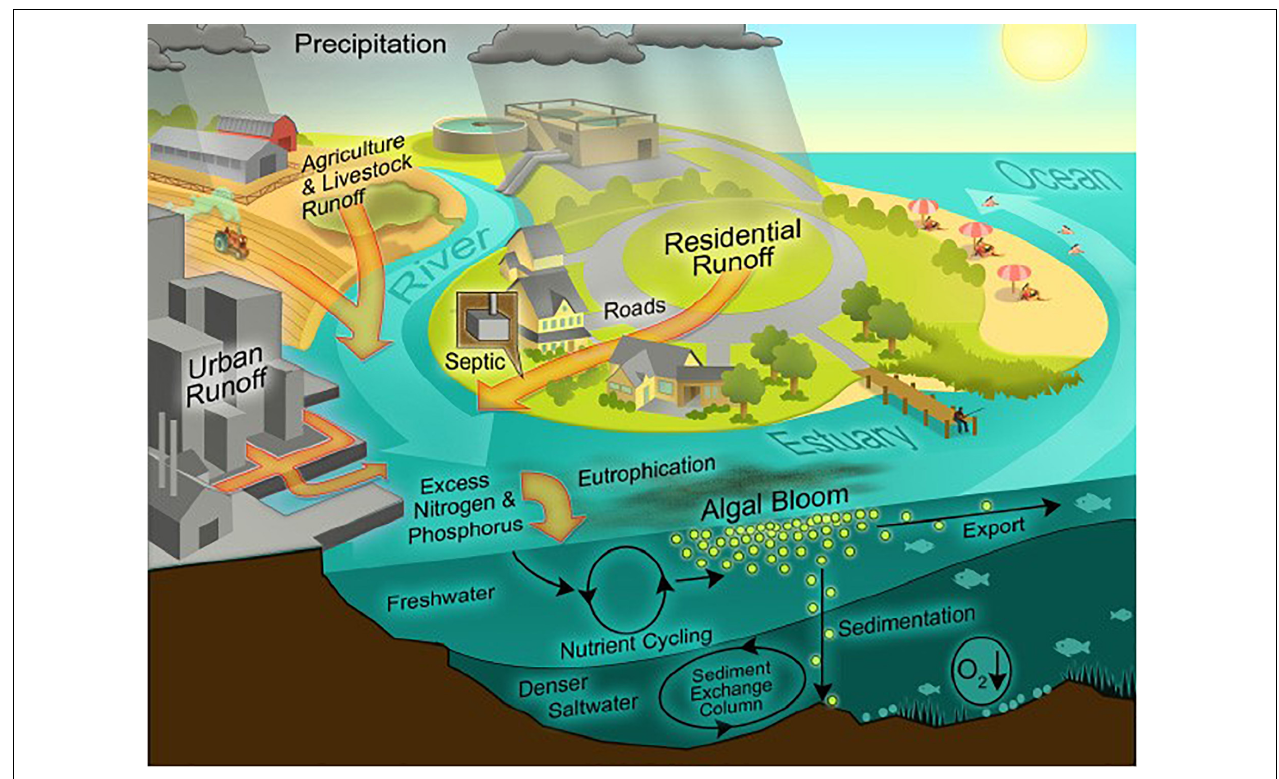
FIGURE 3 | Nutrient enrichment pathways () via river runoff, storm water runoff (Urban and Residential Runoff) and atmospheric precipitation; and effects of anthropogenic nutrient enrichment on phytoplankton biomass (Algal Bloom) and consequences of eutrophication, e.g., oxygen depletion of bottom waters (O 2 ↓ ) (Source: Hans Paerl, University of North Carolina). TABLE 1 | Characteristics of the seven ecosystems (NGM – Northern Gulf of Mexico, ECS – East China Sea, GBR – Great Barrier Reef, BS – Baltic Sea, NA – Northern Adriatic Sea, CB – Chesapeake Bay, Santa Barbara Channel – SBC) compared in terms of ecosystem-surface area ( × 10 3 km 2 ), mean DIN load (10 9 kg N yr − 1 ),